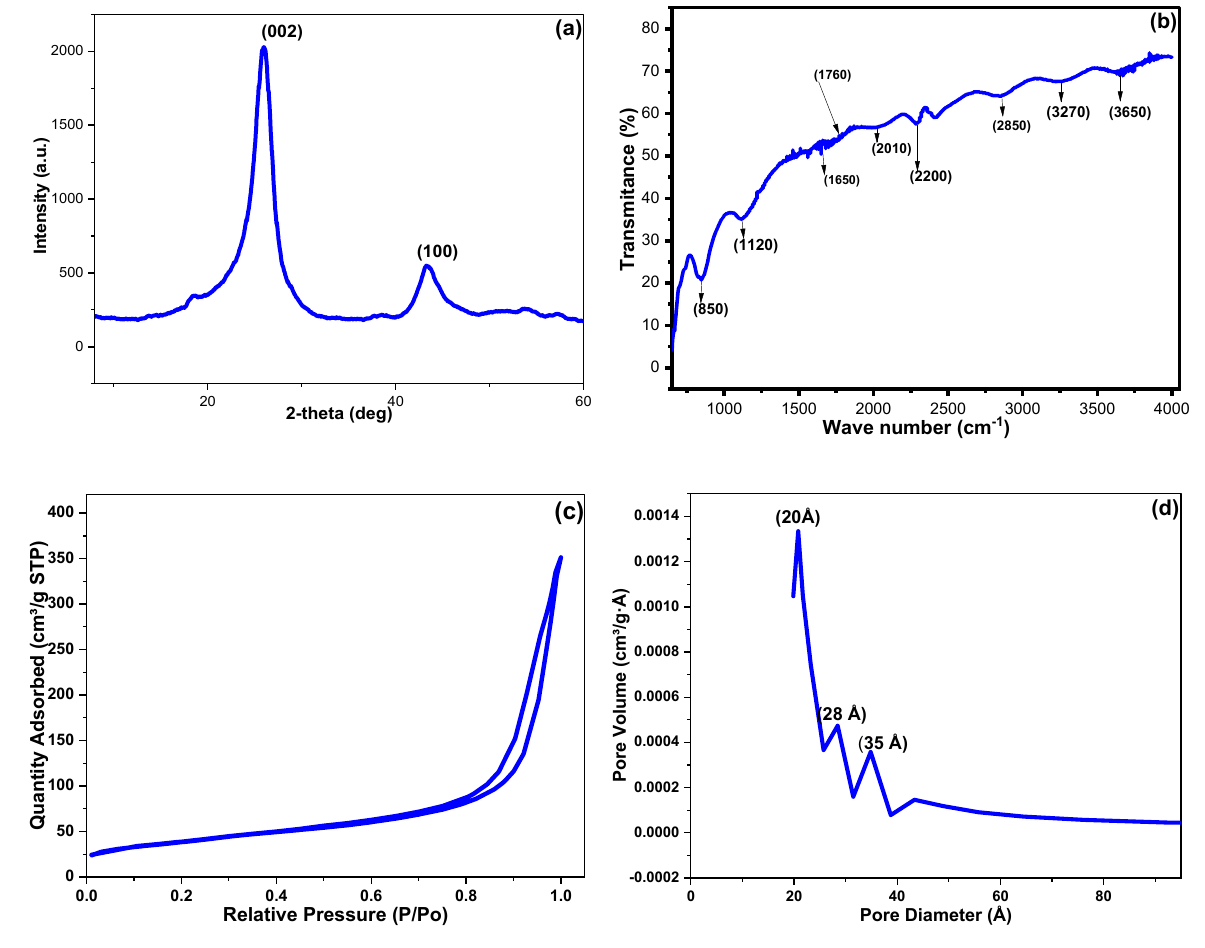
Figure 3. The obtained CNP results via ( a ) powder XRD diffraction spectroscopy, ( b ) FTIR spectros- copy, ( c ) nitrogen adsorption-desorption isotherm, and ( d ) pore diameter distribution.